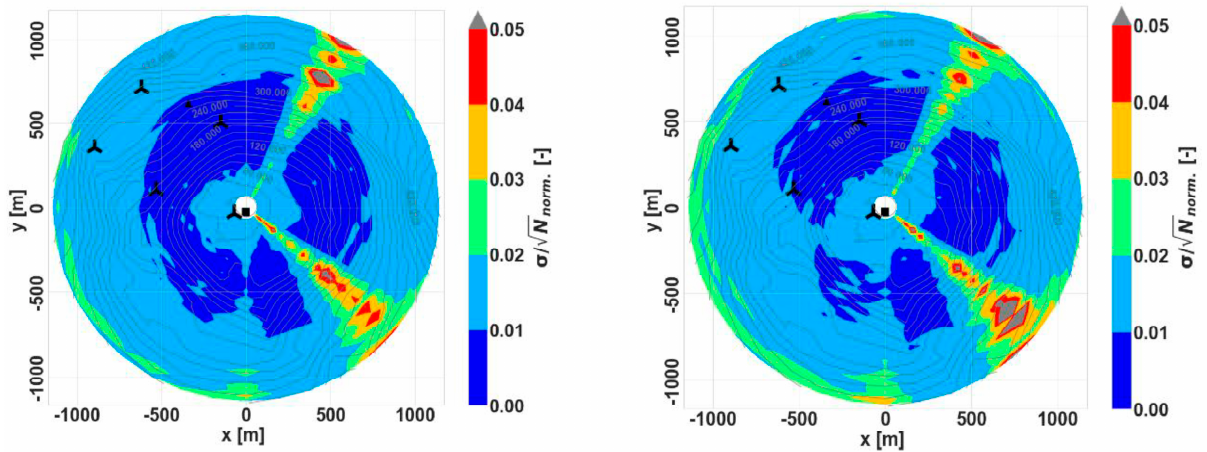
Figure 9. Standard error (defined as standard deviation divided by the number of samples) for the averaged measurement data, i.e., normalized wind speed in LOS direction (𝑣 (cid:3013)(cid:3016)(cid:3020),(cid:3036)(cid:3037) ) (cid:3040)(cid:3032)(cid:3028)(cid:3046)./(cid:3041)(cid:3042)(cid:3045)(cid:3040). , shown in Figure 7a,b.